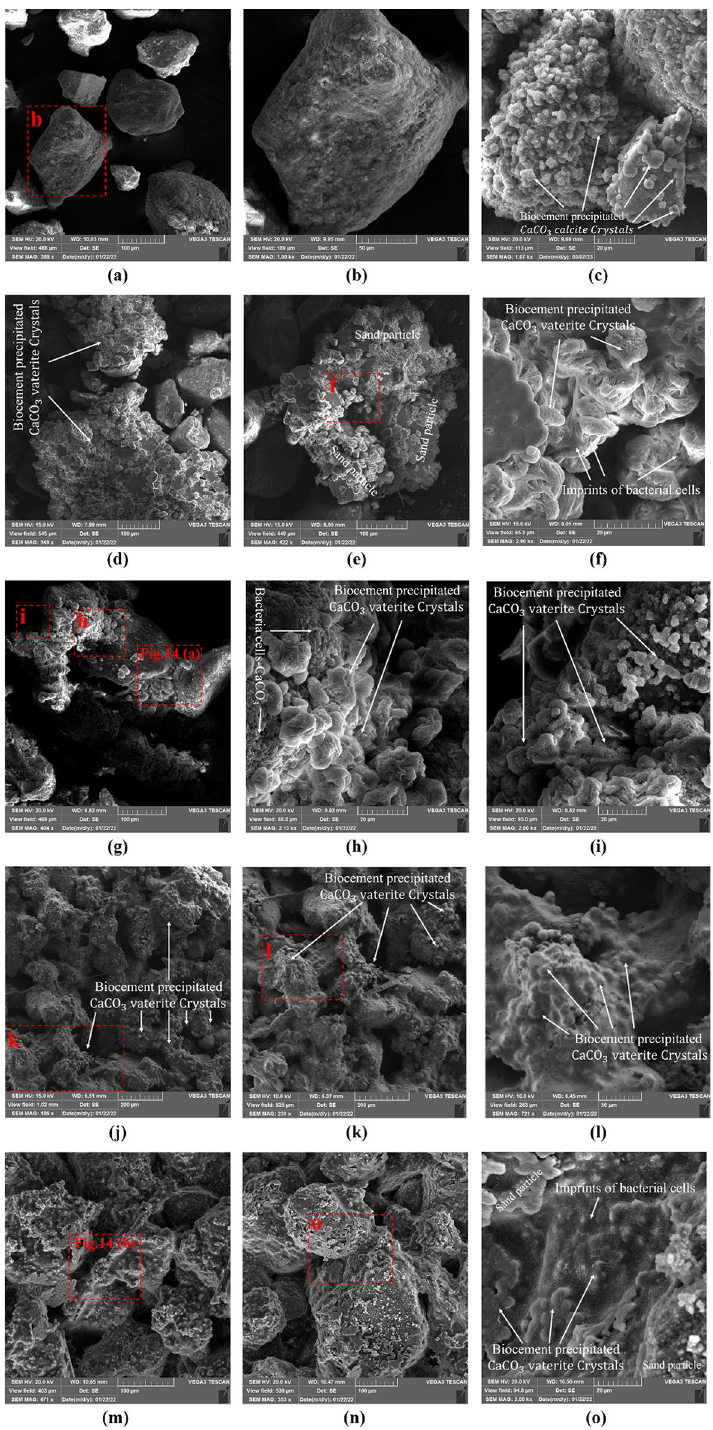
Figure 14. SEM micrograph of ( a , b ) untreated soil, ( c ) control ureolytic MICP, ( d - f ) AA-composition treated sample, ( g – i ) AS-composition treated sample, ( j – l ) FA-composition treated sample, ( m – o ) FS-composition treated sample, at application rate of 3 L/m 2 at different